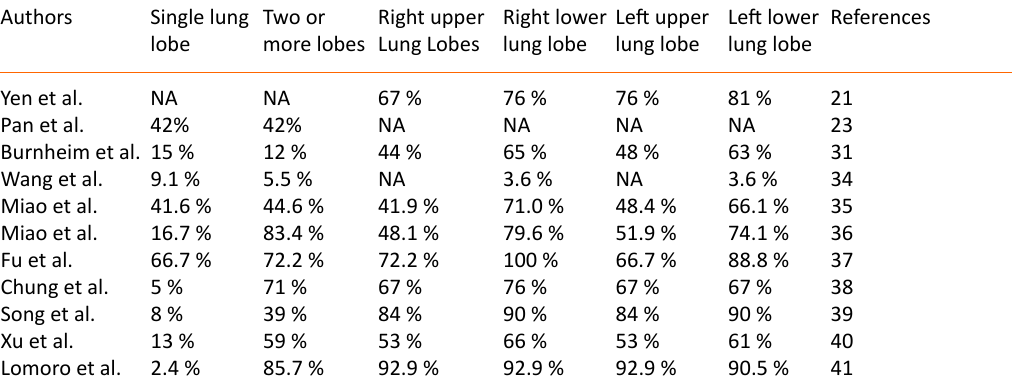
Table 2. Lungs Morphology reported through CT scan in patients infected with COVID-19 Authors Single lung Two or Right upper Right lower Left upper Left lower References lobe more lobes Lung Lobes lung lobe lung lobe lung